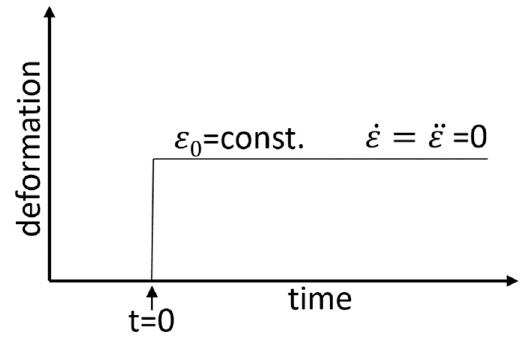
Figure 10. Typical relaxation experiment, applying a prompt deformation ε 0.